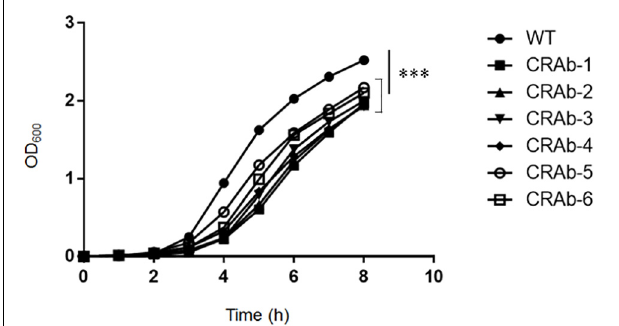
FIGURE 1 | Growth curve of colistin-resistant Acinetobacter baumannii (CRAb) strains. ATCC 19606 (parent) and CRAb strains preadjusted to